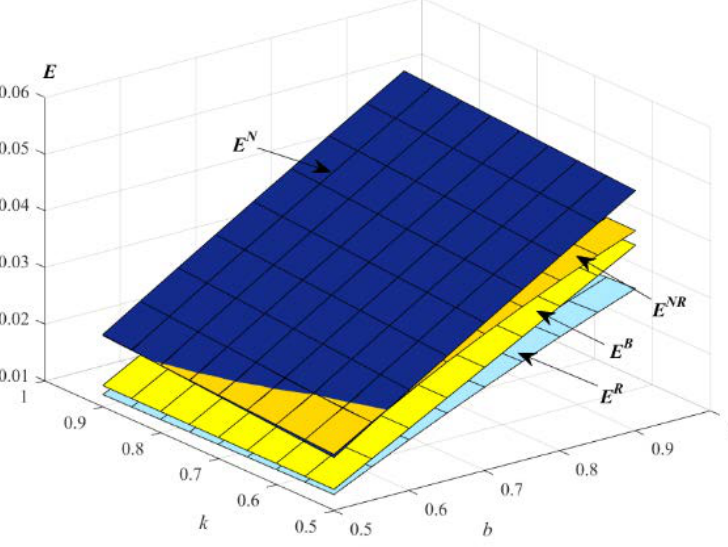
Figure 10. Impact of k and b on the environment.